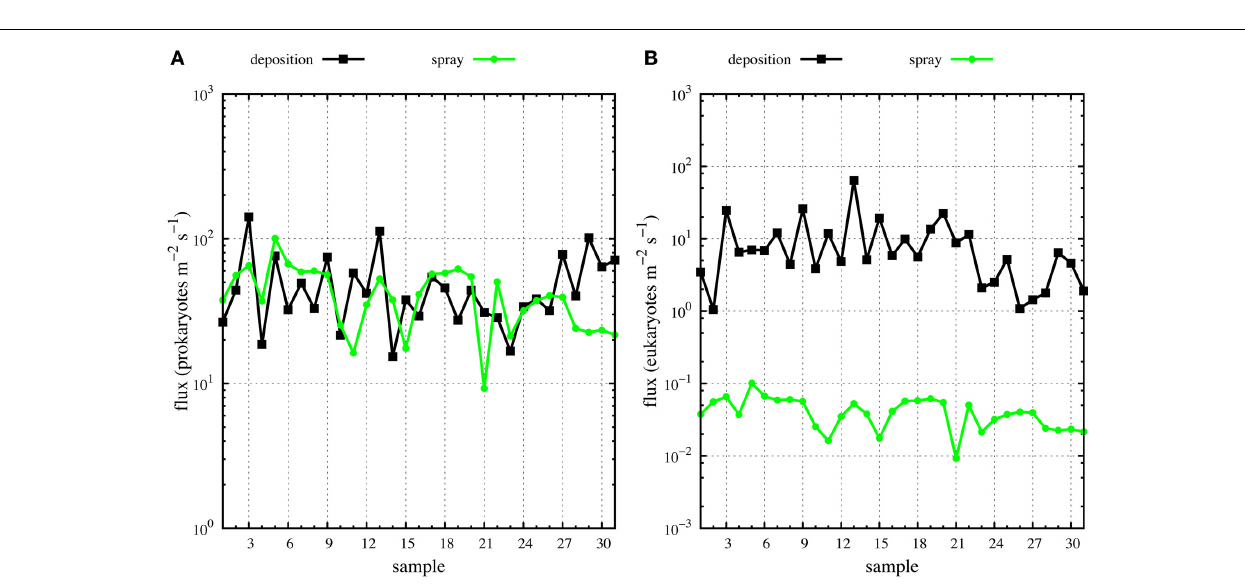
FIGURE 5 | Deposition (black dots) and spray (green dots) fluxes of airborne prokaryotes (A) and eukaryotes (B) along MEDEA-II